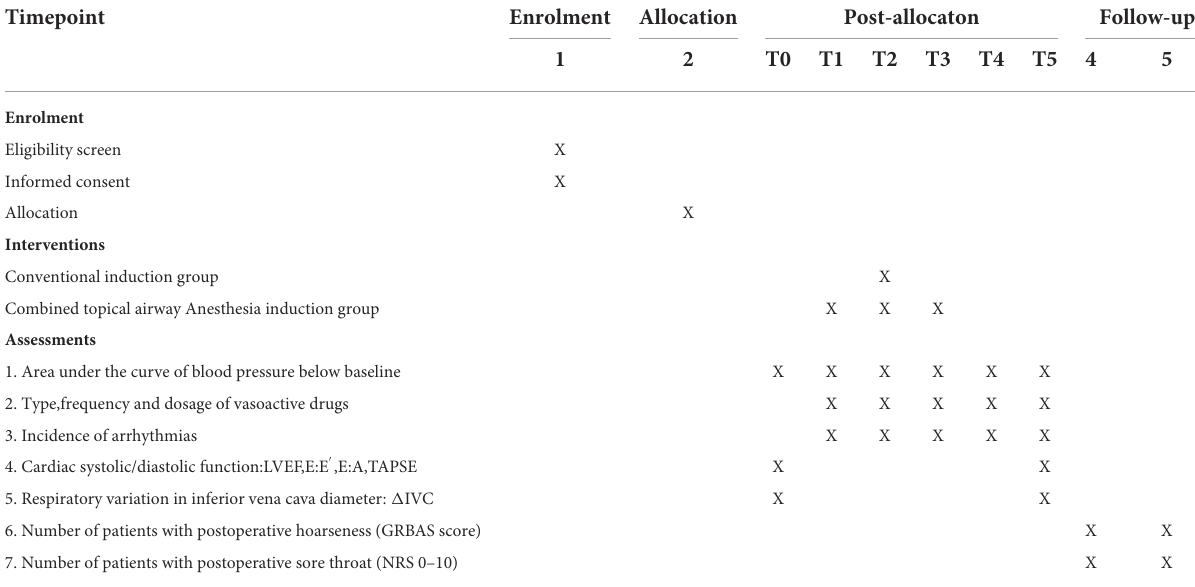
TABLE 1 Time schedule of enrolment, interventions, assessments, and visits for the participants. Timepoint Enrolment Allocation Post-allocaton